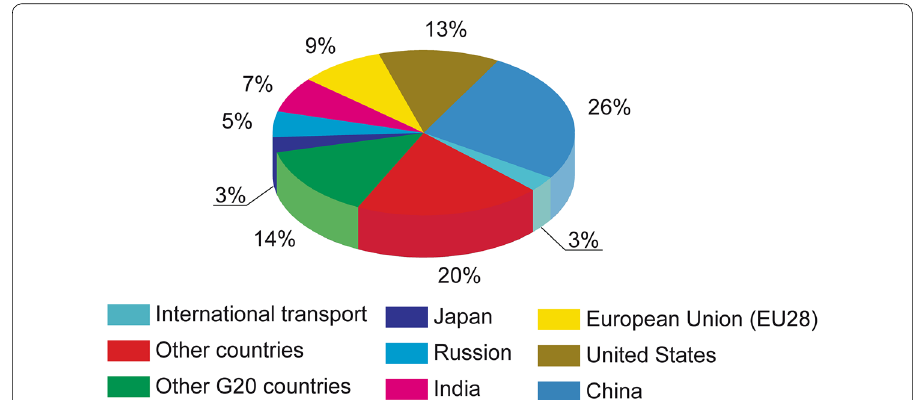
Fig. 3 Global greenhouse gas emissions in 2016 (excludes emissions related to forests and other land uses. G20, the group containing the 20 largest